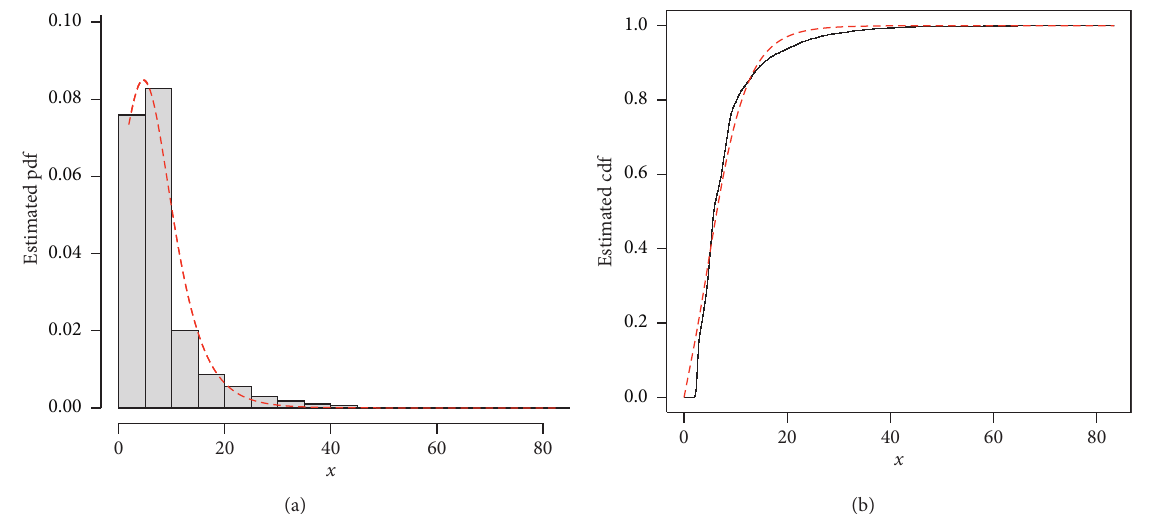
Figure 9: Fitted pdf and cdf of the ETX-Weibull distribution for the automobile insurance claim data set.